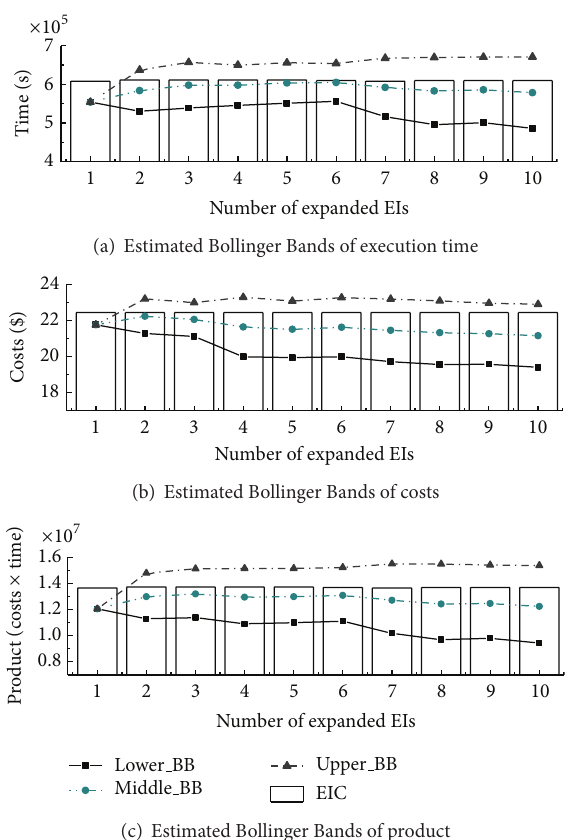
Figure 13: Estimated execution time, cost, and Bollinger Bands of expanded EI zones computed with the past price history.